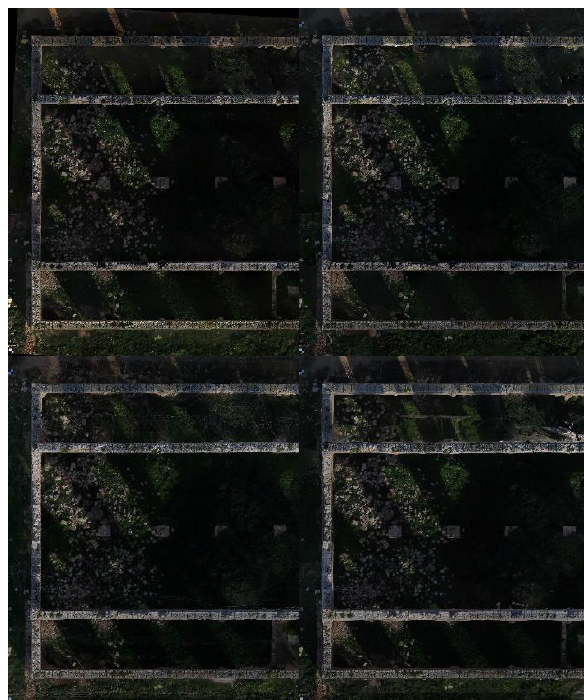
Figure 19. Comparison among different plans from images: from us (a), from SBM2017 participants (b, c, d).